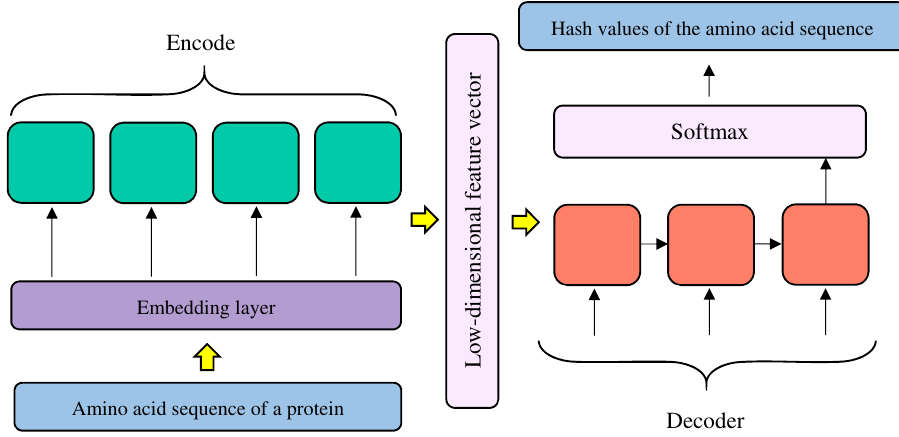
Figure 2. Protein feature selection based on the